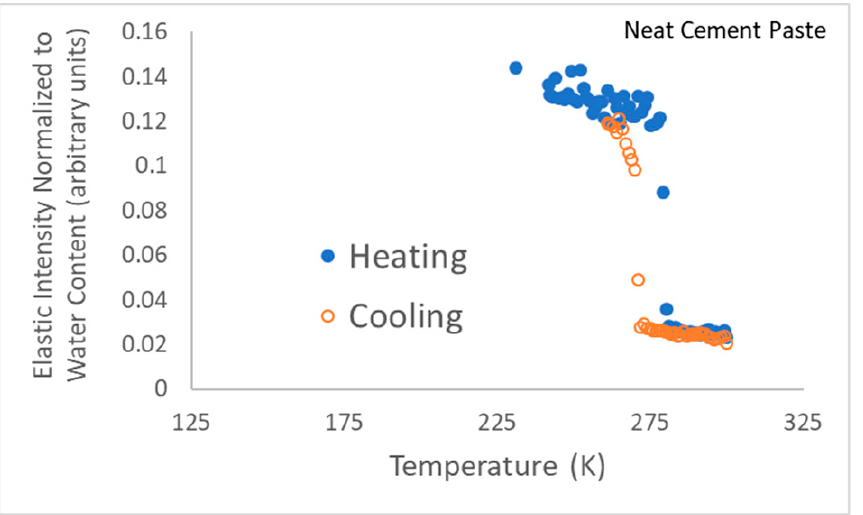
Figure 8. Energy-resolved “elastic” scattering data for neat cement paste, i.e. , without gel. Note that this neutron scattering run was terminated just after the phase transition since the team’s neutron beamtime was running out.